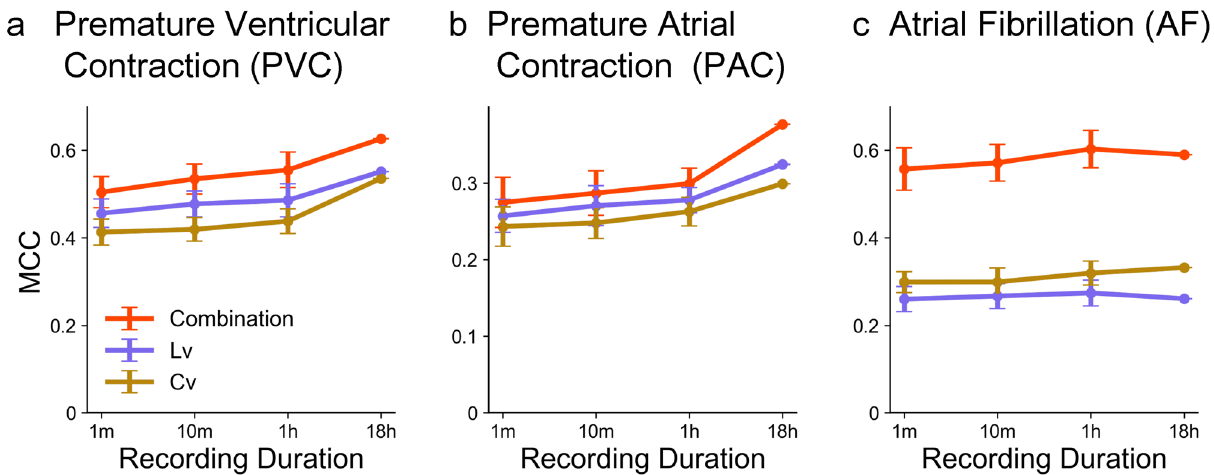
Figure 4. The MCCs for Cv and Lv , and the combination method based on datasets with various recording durations: 1 minute, 10 minutes, 1 hour, and 18 hours. ( a ) PVC, ( b ) PAC, and ( c ) AF. The MCCs for the shorter recording durations are represented with the mean and standard